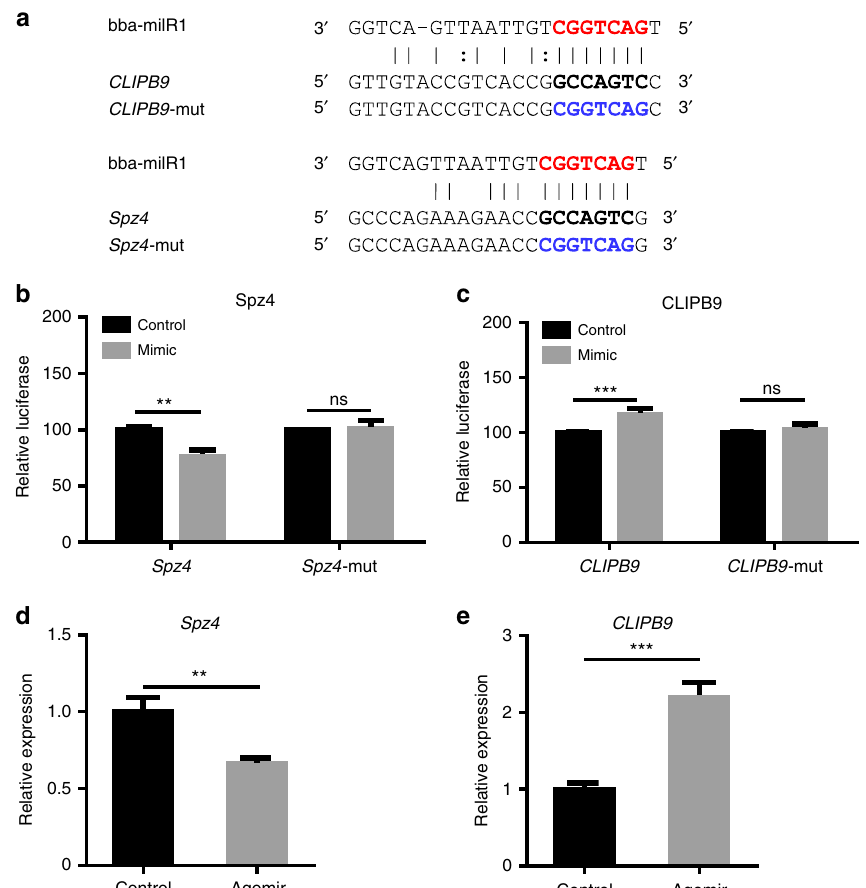
Fig. 3 bba-milR1 targets the mosquito genes Spz4 and CLIPB9 . a The sequences of bba-milR1 target sites in the coding regions of Spz4 and CLIPB9 genes of A. stephensi mosquito. Red characters are seed regions of bba-milR1. Black bold characters are target sequences. The mutated forms of target genes are shown in blue characters. b bba-milR1 suppresses Spz4 expression. c bba-milR1 induces CLIPB9 expression. The interactions between bba-milR1 and the target sites of Spz4 and CLIPB9 in A. stephensi were determined by dual-luciferase reporter assays in HEK293T cells that were co-transfected with bba-milR1 mimics and psiCHECK2 vectors containing wild or mutant target sequences of Spz4 or CLIPB9 genes. d The transcript level of Spz4 is suppressed in mosquitoes injected with bba-milR1 agomir (200 nM). The mosquitoes injected with control agomir (200 nM) served as a negative control. Gene expression was quanti fi ed by qRT-PCR. e The transcript level of CLIPB9 is upregulated in mosquitoes injected with bba-milR1 agomir compared with the control. Values are mean ± s.e.m. The expression values are normalized to control. The experiments were repeated three times with similar results. ** P < 0.01, *** P < 0.001, ns, not signi fi cant (Student ’ s t test). Source data are provided as a Source Data fi